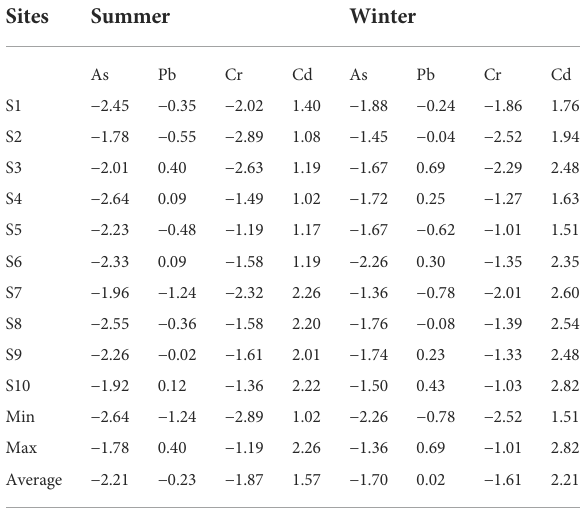
TABLE 3 I geo values of the metal contents in the sediment of the Rupsha River, Bangladesh. Sites Summer